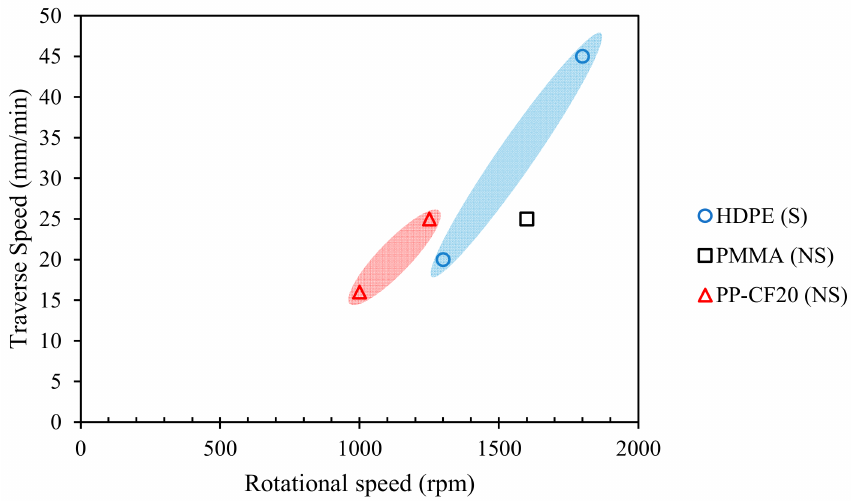
Figure 4. Optimal rotational and traverse speeds for achieving maximum joint strength for lap-joint FSW of thermoplastic sheets. NS = Non-Submerged, S =